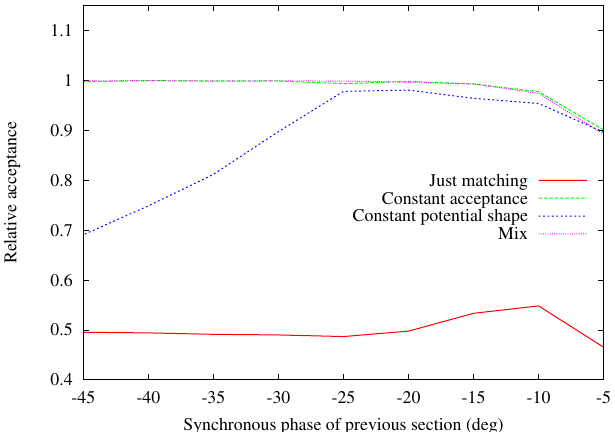
FIG. 5. (Color) The relative acceptance of the linacs with fre- quency jumps in respect to the initial synchronous phase. The reference is the linac without frequency